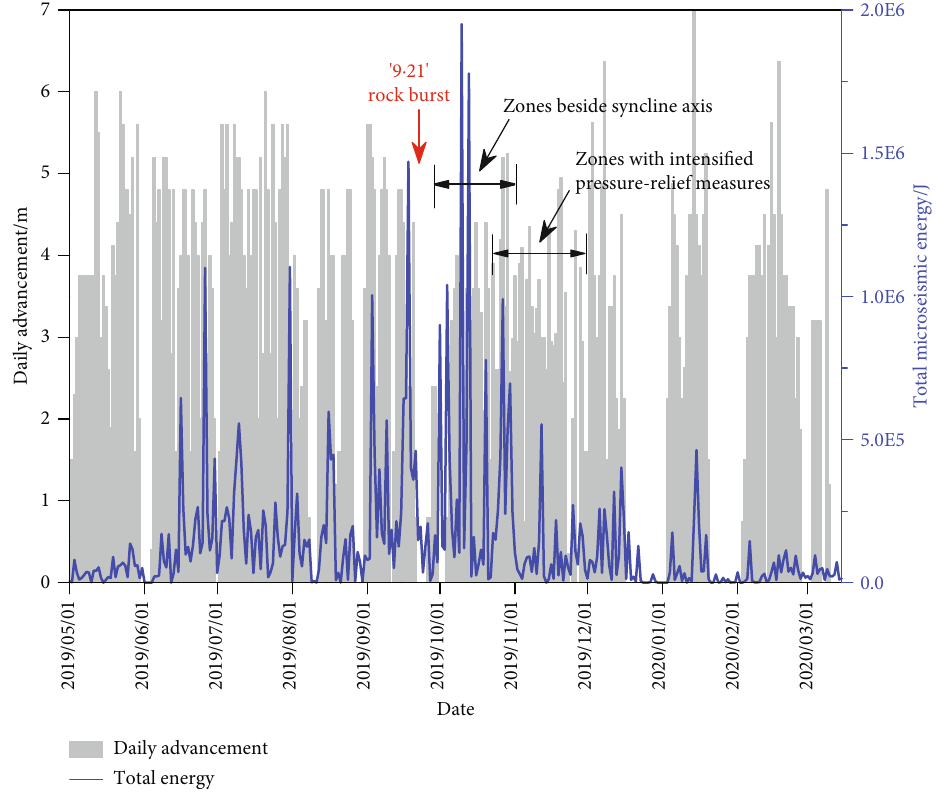
Figure 11: Microseismic activity of panel 204 between 1 May 2019 and 15 March